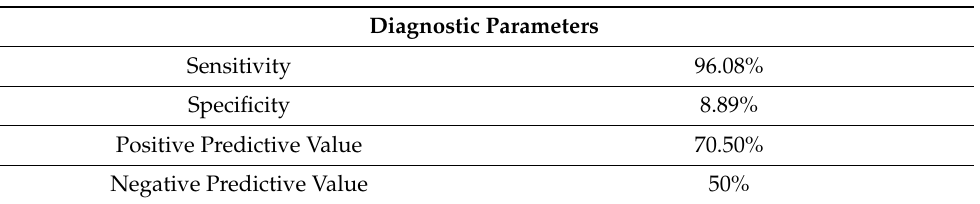
Table 4. Diagnostic reliability on the whole